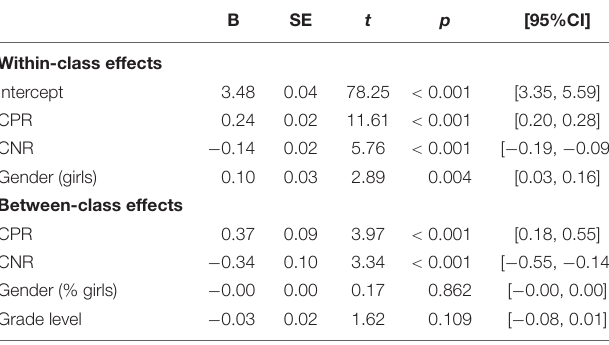
TABLE 2 | Conditional positive and negative regard as predictors of behavioral engagement: Unstandardized within-class and between-class coefficients. B SE t p